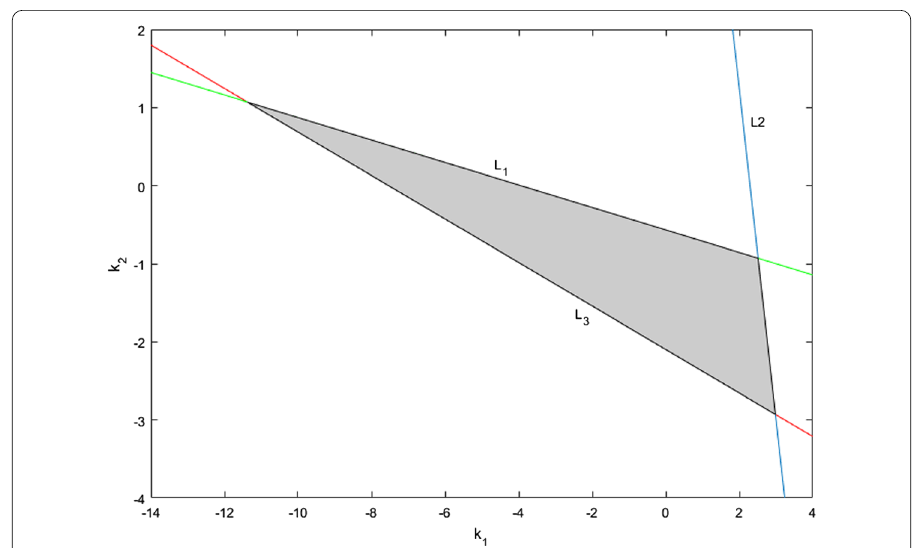
Figure 7 The stability region of controlled system (4.6) in the ( k 1 , k 2 ) plane for s = 3, m = 3, β = 0.2, e 1 = 1.2, e 2 = 0.3